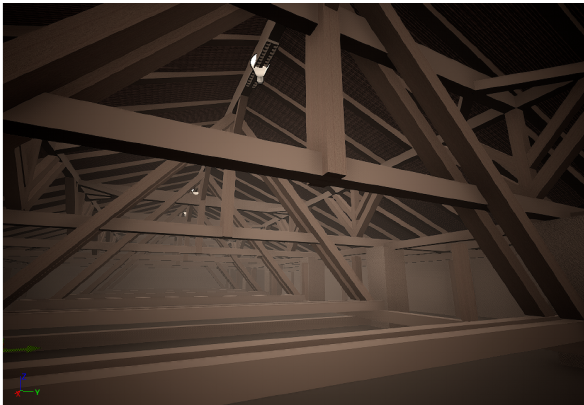
Figure 3 . View of the roof construction.